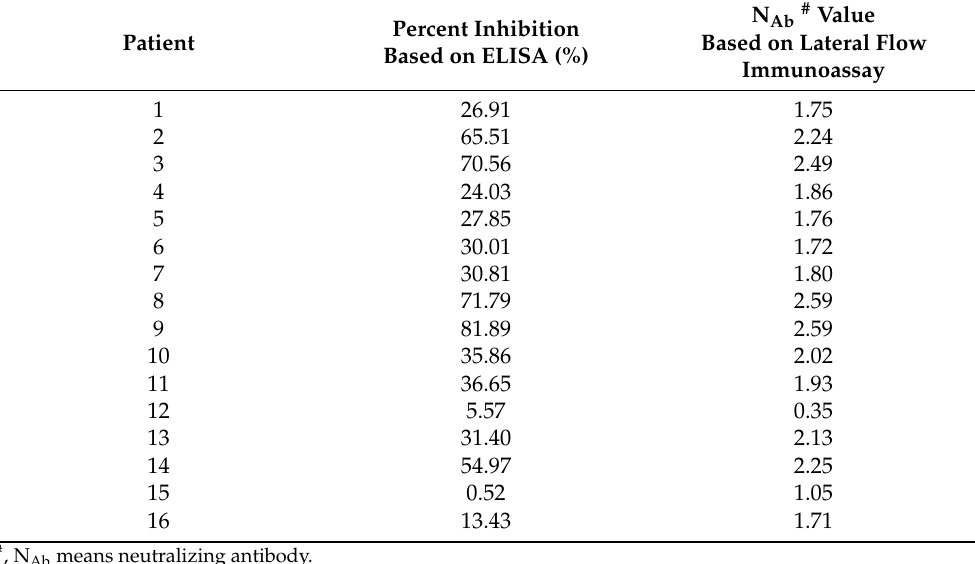
Table 2. Results summary of the lateral flow immunoassay and ELISA of vaccinated persons.